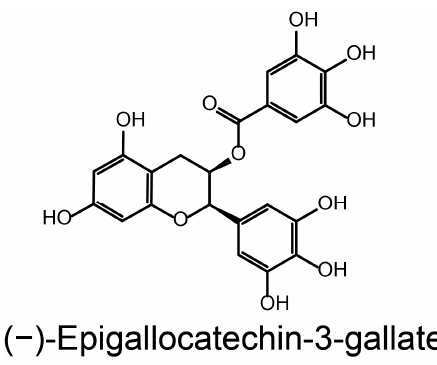
Figure 1. The structure of EGCG.